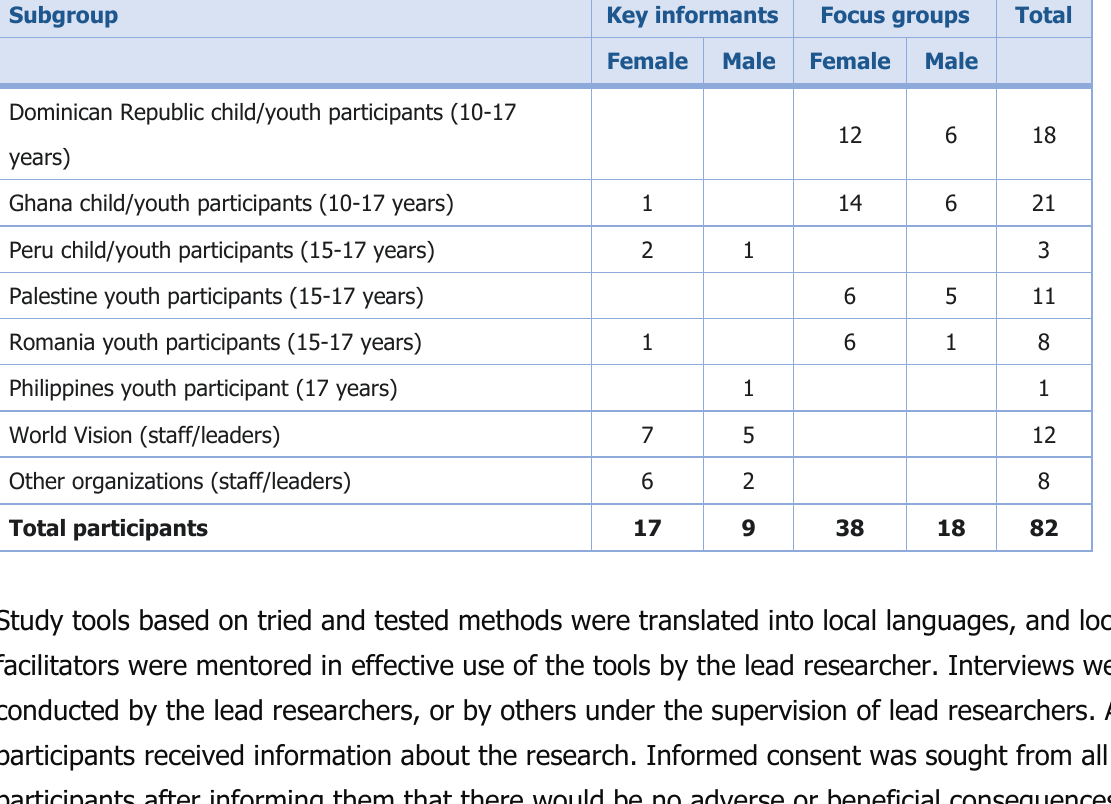
TABLE 1. Participant by Country and Subgroup Subgroup Key informants Focus groups